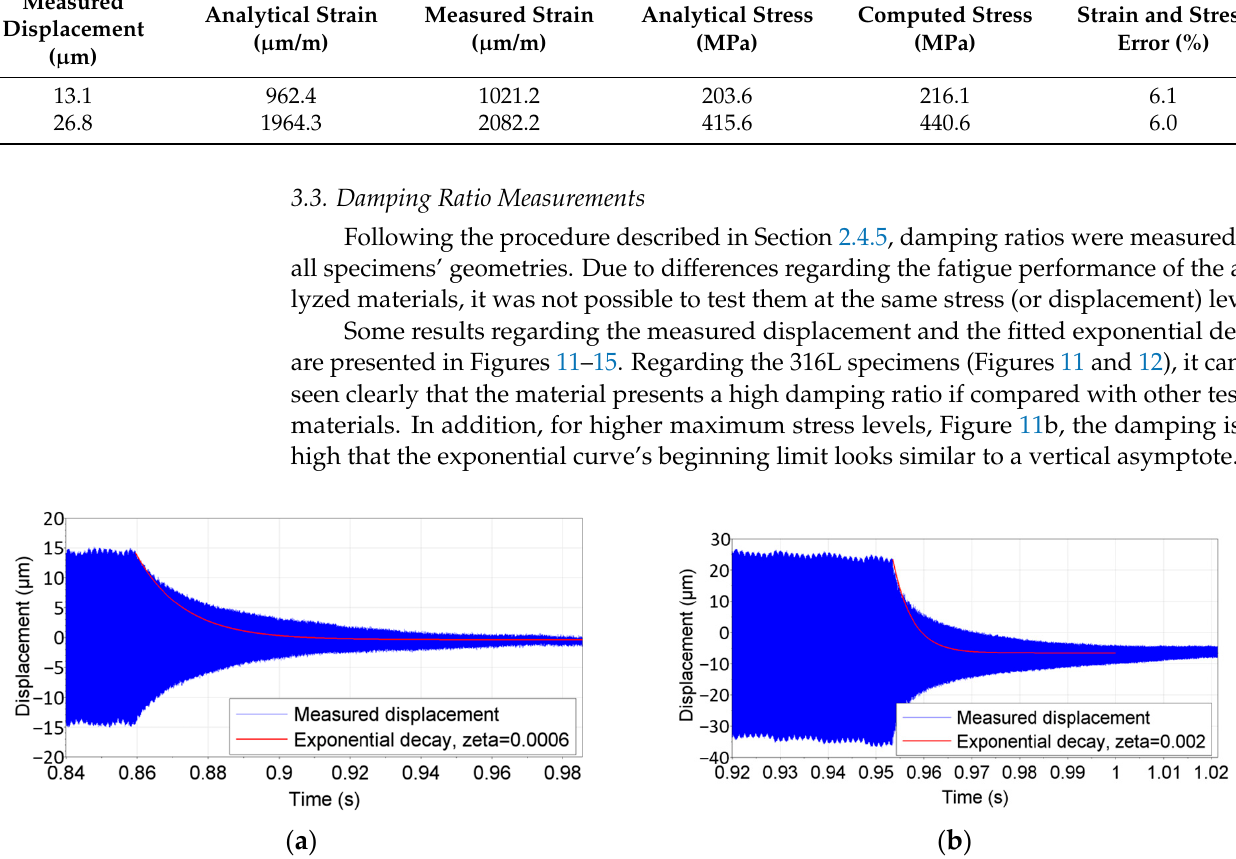
( b ) Figure 12. SS 316L D3, UHCF specimen, exponential decay: ( a ) Maximum stress = 204 MPa; ( b ) Maximum stress = 350 MPa. The 51CrV4 (Figure 13) and the Inconel 625 (Figure 15) were the materials that pre- sented the lowest damping ratio. The S690 (Figure 14) damping properties were located between these and the 316L ones. ( a ) ( b ) Figure 13. 51CrV4 steel, UHCF specimen, exponential decay: ( a ) Maximum stress = 400 MPa; ( b ) Maximum stress = 600 MPa.